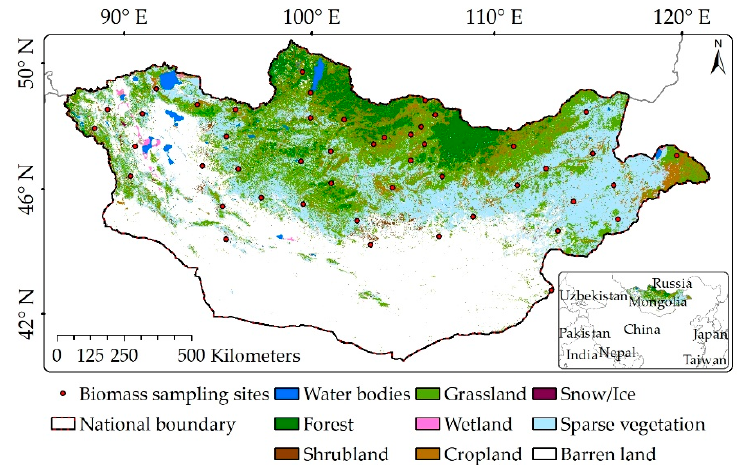
Figure 1. Location map of the study area and the distribution of main land cover categories in Mongolia (derived from the Climate Change Initiative Land Cover (CCI-LC) product for 2015, as explained in Section